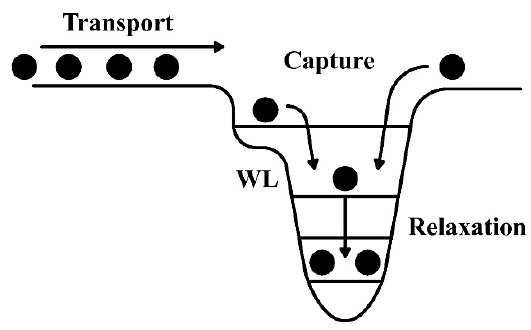
Figure 12. Schematics of carrier dynamics for QDs.